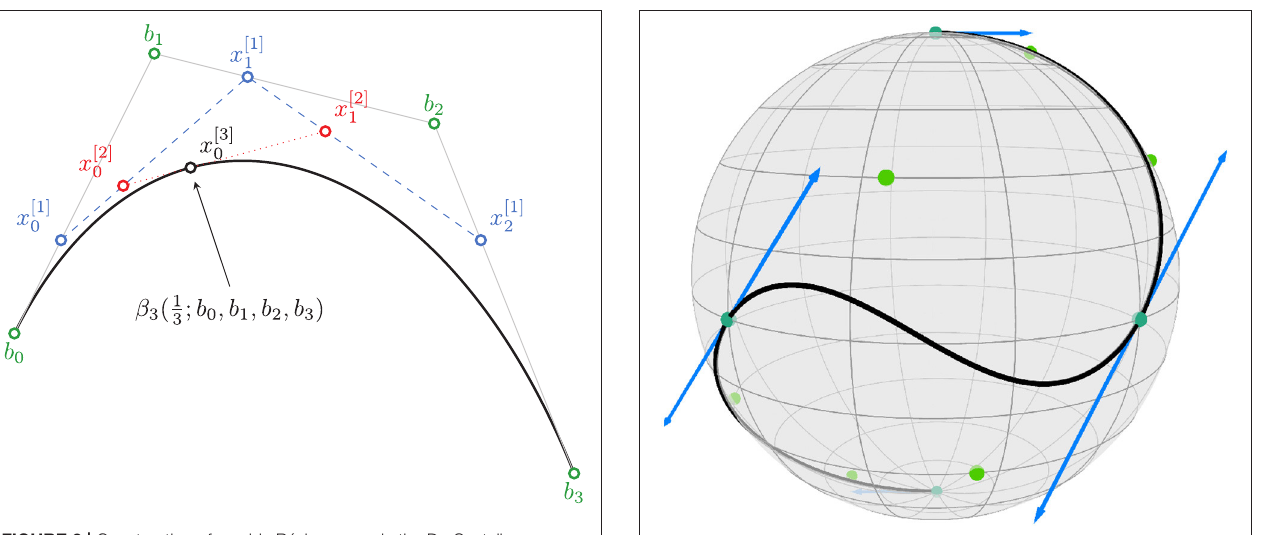
S 2 . The end points → b ± i , i